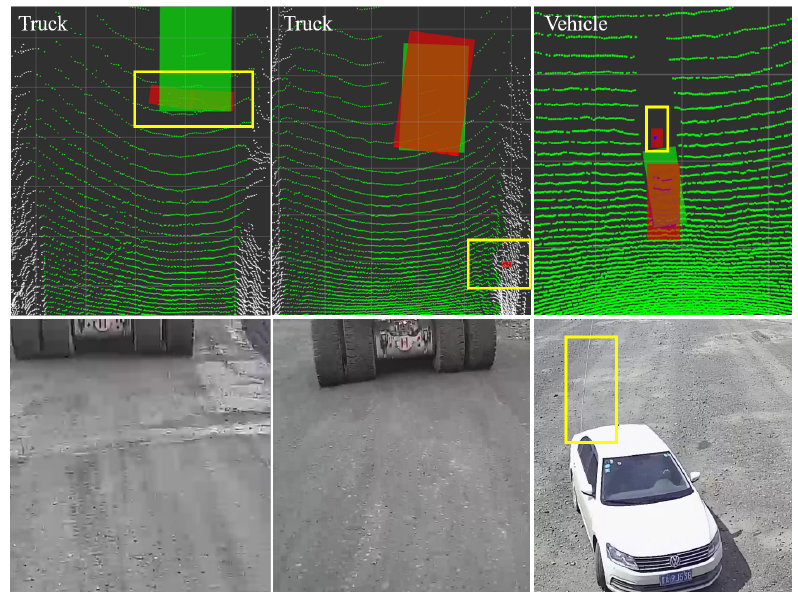
Figure 10. Failure cases using the same visualized setup as that in Figure 9. The yellow rectangle represents the target of the failed